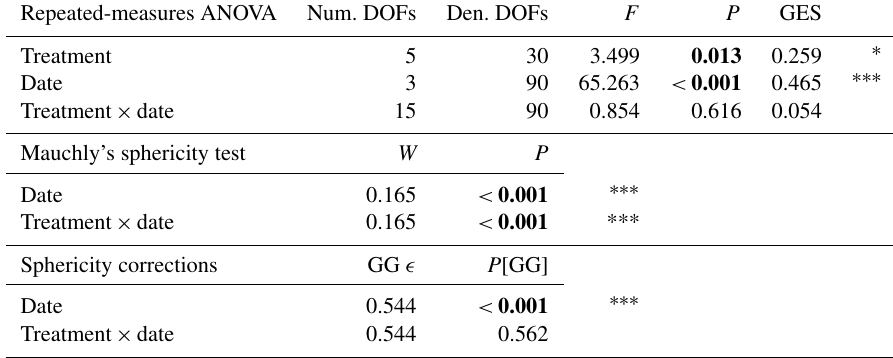
Table A1. Effect of Collembola addition on daily CO 2 production over time, repeated-measures ANOVA. P [GG] indicates repeated- measures ANOVA P using Greenhouse–Geisser correction to degrees of freedom to account for violation of the assumption of sphericity (Mauchly’s test). P values below 0.05 are denoted in bold; ∗∗∗ P < 0.001; ∗ 0.01 <P < 0.05. Num. DOFs: numerator degrees of freedom; Den. DOFs: denominator degrees of freedom; GES: generalized Eta-squared measure of effect size; GG (cid:15) : Greenhouse–Geisser (cid:15) . Repeated-measures ANOVA Num. DOFs Den. DOFs F P